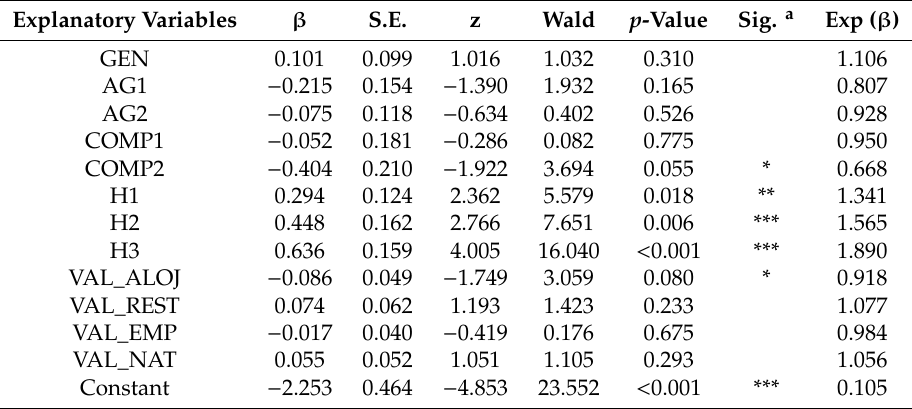
Table 1. Estimation of the binary logistic regression model